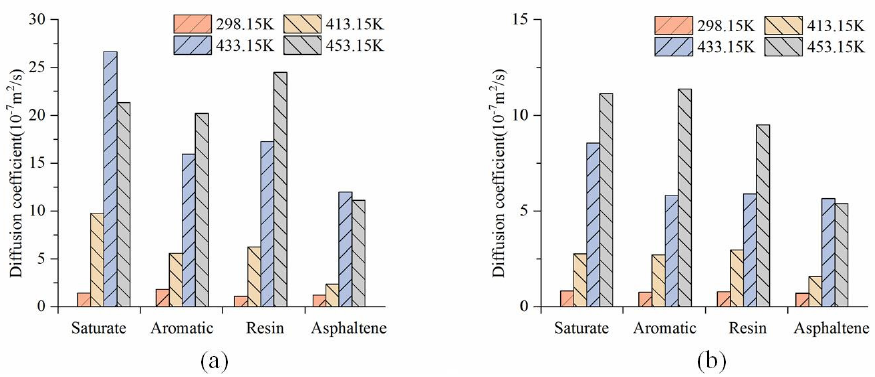
Figure 14. Self − di ff usion coe ffi cients of components at di ff erent temperatures: ( a ) virgin–aged as- phalt; ( b ) virgin asphalt–RAM. asphalt; ( b ) virgin